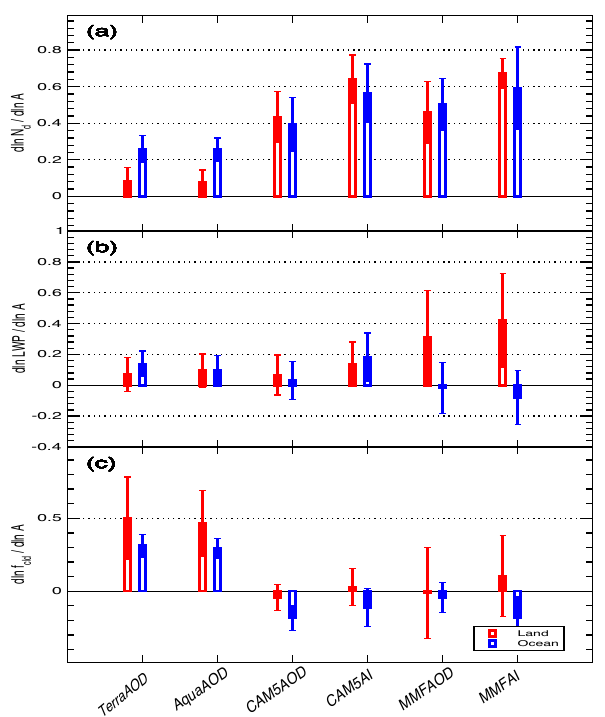
Figure 11 Fig. 11. Sensitivities of (a) cloud-top droplet number concentra- tion, (b) cloud liquid water path, (c) cloud fraction to perturbations in column-integrated aerosol number concentration proxies repre- sented by either AOD or AI as obtained from the linear regres- sions in PD. The weighted averages for four seasons and all six land regions (red) and eight ocean regions (blue) are show, with the variability as error bar. Results are shown for MODIS Terra (Ter- raAOD: cloud parameters vs. AOD); MODIS Aqua (AquaAOD: cloud parameters vs. AOD); CAM5 (CAM5AOD: cloud parameters vs. AOD, CAM5AI: cloud parameters vs. AI); MMF (MMFAOD: cloud parameters vs. AOD, MMFAI: cloud parameters vs.